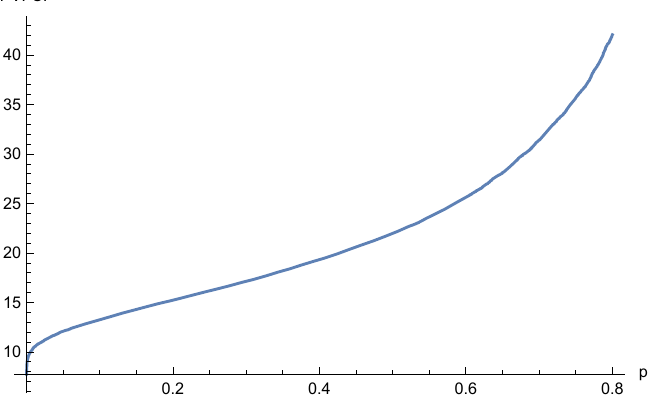
Figure 4. Quantile function of the total portfolio value for different p